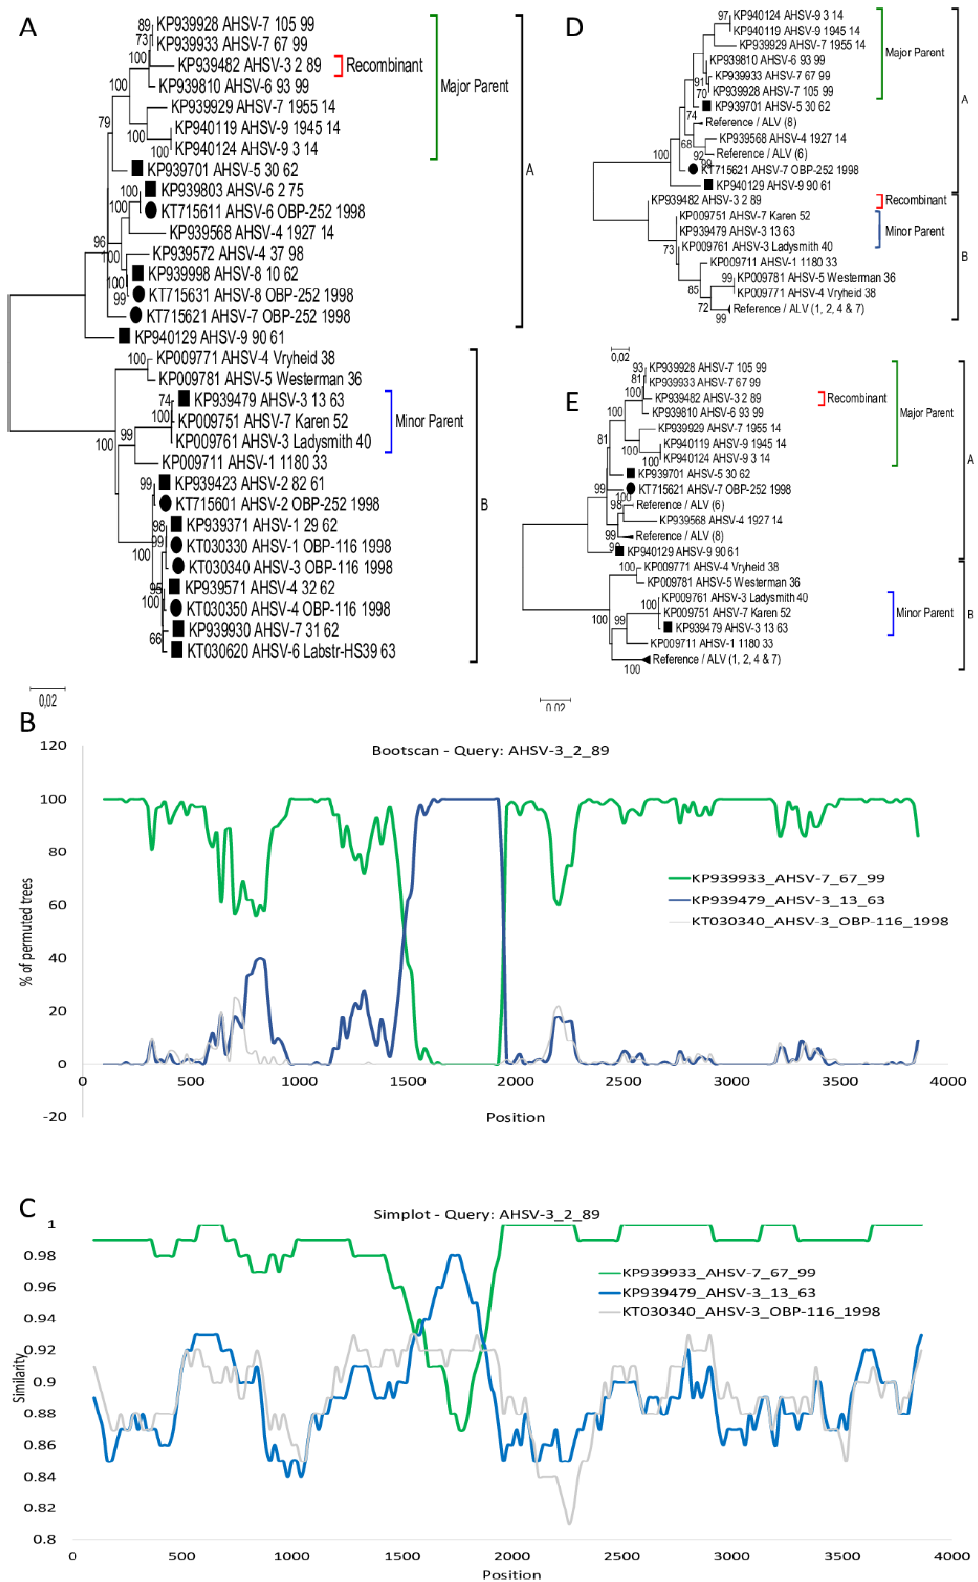
Figure 1. Evidence of intragenic recombination in Segment-1 of KP939482_AHSV-3_2_89. ( A ) ML phylogenetic tree showing the relationship of segment-1 in selected African horse sickness virus (AHSV) isolates. Reference isolates are indicated with a square and attenuated live virus (ALV) sequences with a circle. ( B ) BootScan results of KP939482_AHSV-3_2_89 with its parents